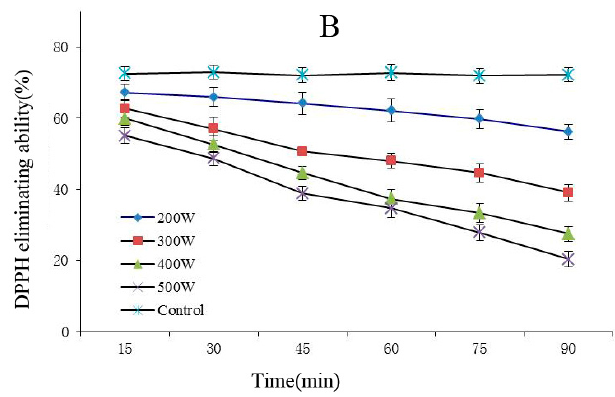
Figure 5. Effect of power ultrasound on the antioxidant activities of Cy-3-glu as measured by FRAP ( A ) and DPPH ( B ) ( n = 3).